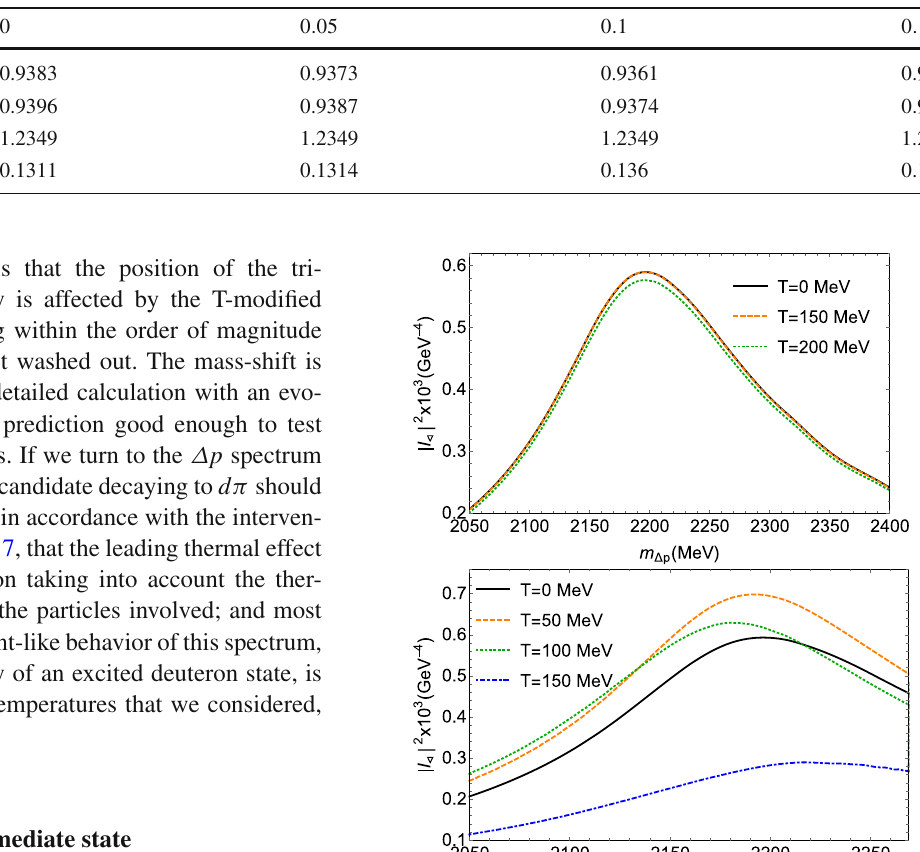
Table 2 Input p , n baryon thermal masses (in GeV) extracted from [42]; input Δ + thermal width (in GeV) extracted from Eq. (21) of [47], taking g Δ = 2 . 38 ,Λ = 400 MeV and the T -dependent values of f π according to [48]